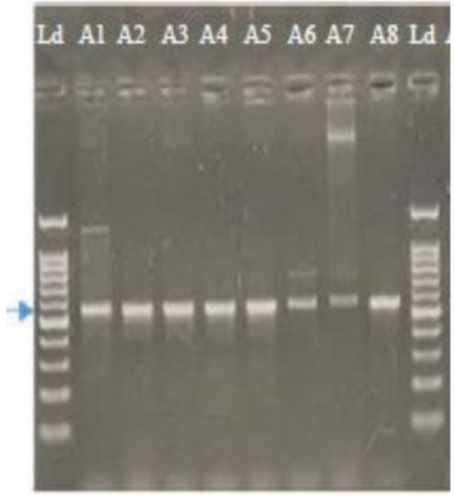
Figure 1. Gel image showing 570 bp (arrowhead) DNA fragment amplified by ITS (1 and 4) primer in A. solani isolates on 1.2% agarose gel electrophoresis. Ld is the l kb RTU 1151021805 ladder.